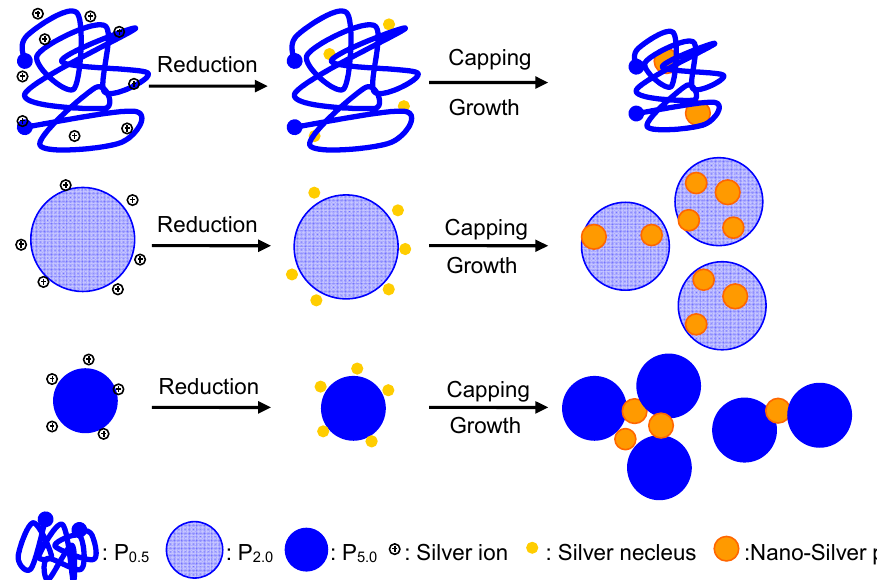
Figure 5. Schematic model for formation of EPS-AgNP complexes.